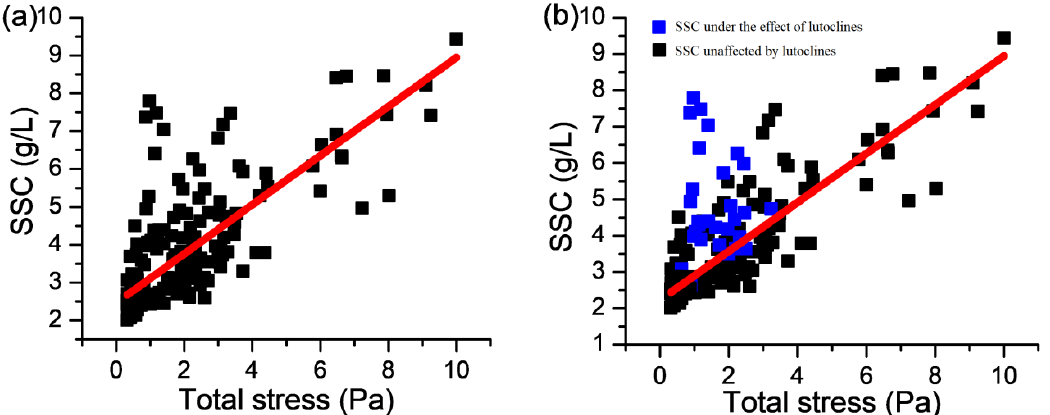
Figure 14. ( a ) The near bed SSC from 19 December 2016 to 12 January 2017 as a function of the shear stress calculated using Equation (6) (linear fit of the total stress Pearson’s r is 0.75). ( b ) The near SSC from 19–26 December 2016 and from 6–13 January 2017 as a function of the shear stress calculated by Equation (6) (blue points are the SSC calculated by Equation (6) from 27 December 2016 to 5 January 2017. The linear fit of the total stress Pearson’s r is 0.88).